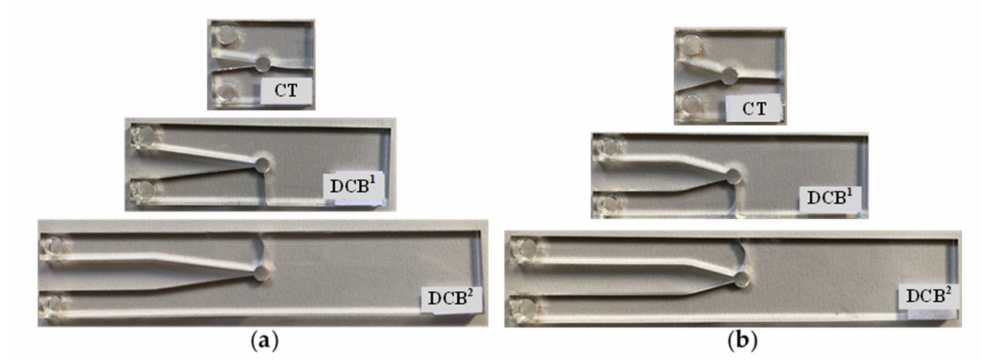
Figure 7. CT, DCB 1 , and DCB 2 VO-notched specimens fractured under mode I loading condition. P = 2.5 mm. ( a ) γ = 15 ◦ ; ( b ) γ = 30 ◦